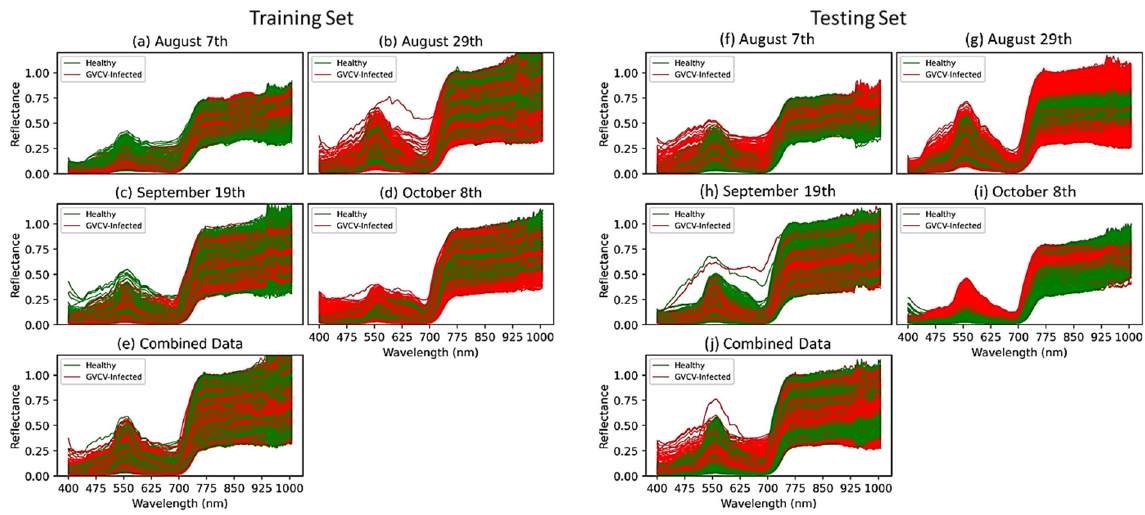
Figure 3. Pseudo red-green-blue (RGB) hyperspectral images in the training set ( n = 24 images) and testing set ( n = 16 images). The image dimensions are 512 × 512 pixels × 203 spectral bands. The row order corresponds to the measuring dates (August 7th, August 29th, September 19th, and October 8th). Training images (3 healthy and 3 GVCV vines) were randomly selected from each measure. Image backgrounds (soil, grass, sky, etc.) were masked out and only grapevines pixels were retained after the segmentation task. The August 7th images (first row) were acquired at a vertical (nadiral) angle. Subsequent images were acquired at a horizontal (lateral) angle.